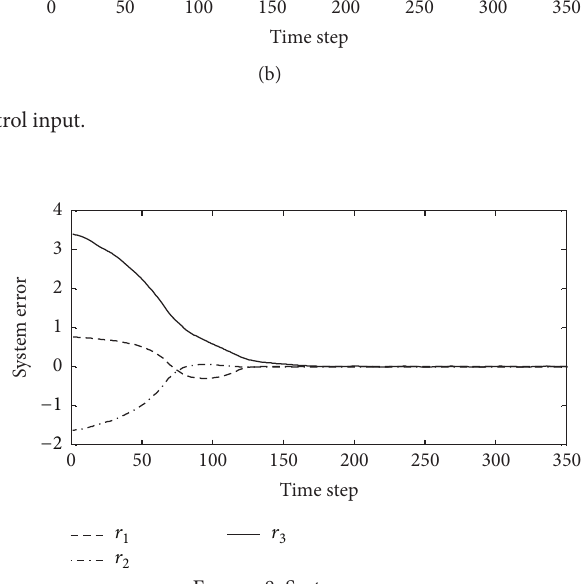
Figure 8: System